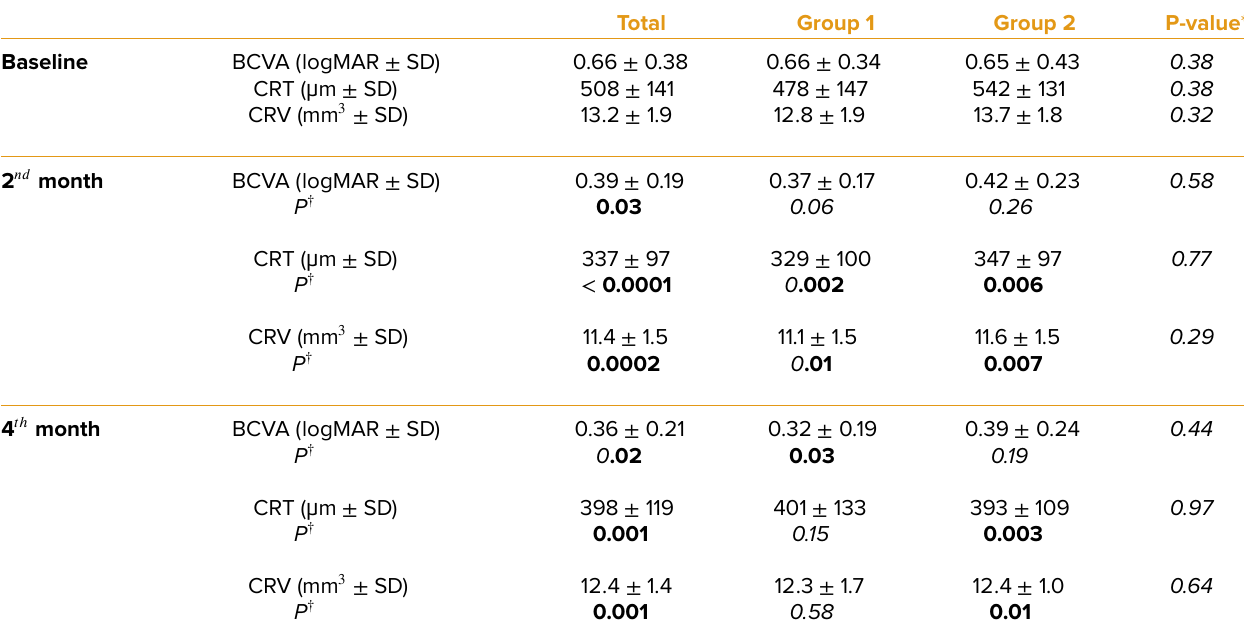
Table 2. The mean BCVA, CRT, and CRV before and after the treatment at months 2 and